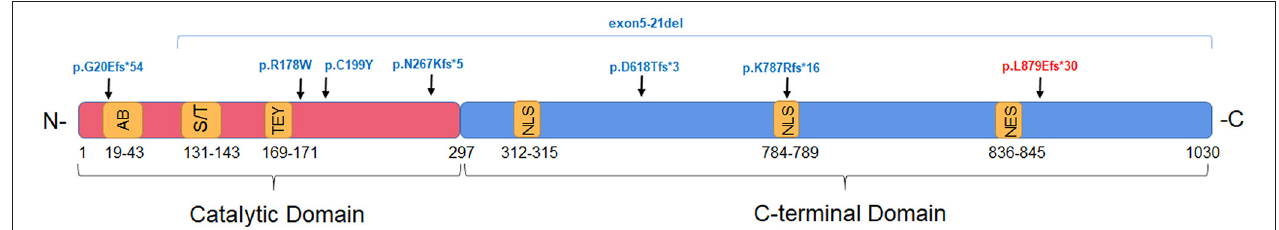
FIGURE 2 | The schematic graph indicating the locations of CDKL5 variants in functional domains in patient with IS. CDKL5 mutations identified in responders and non- responders to KD treatment are indicated in blue and red, respectively. Functional motifs are labeled in yellow: AB, ATP binding site; S/T, Ser/Thr kinase active site; TEY, Thr/Glu/Tyr motif; NLS, nuclear localization signal; NES, nuclear export signal.